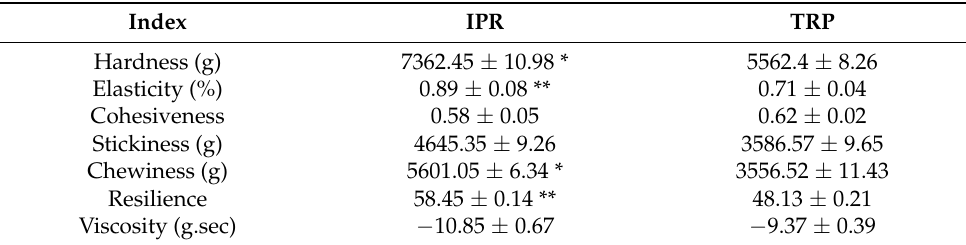
Table 4. Muscle texture characteristics of the fish cultured in IPR and TRP.